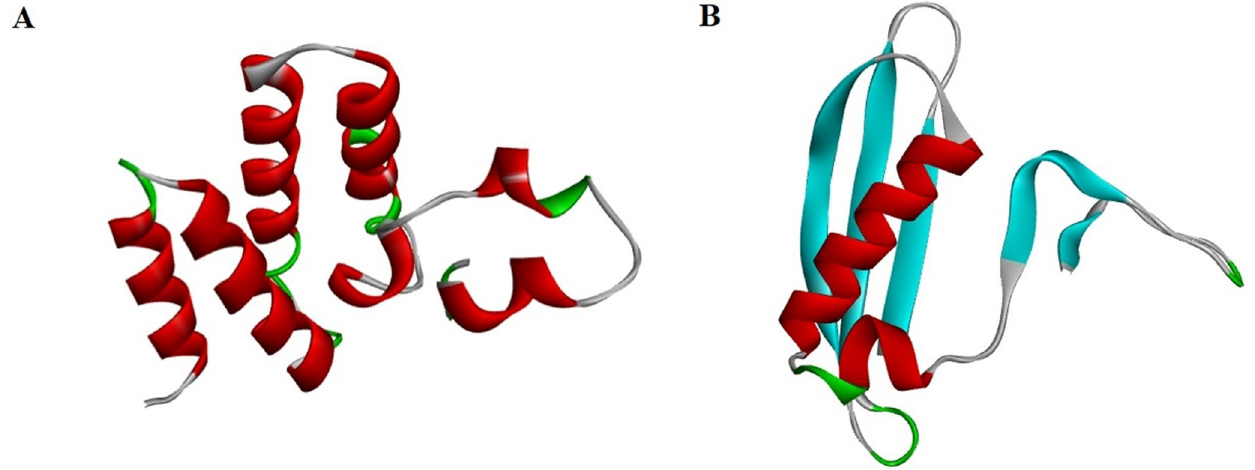
Fig 2. The best models’ 3D structures of A) ht-MAP2191 and B) ht-FAP-P after